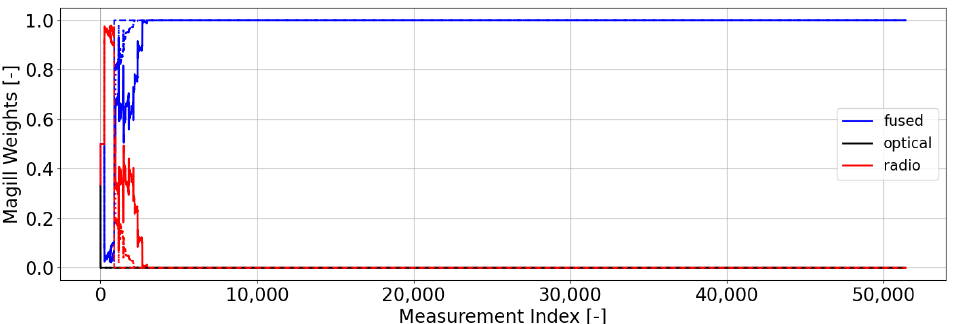
Figure 15. Magill gating network weights with biased radiometric measurements. Small (solid lines), medium (dotted lines), and large (dashed lines) biasing cases are included.